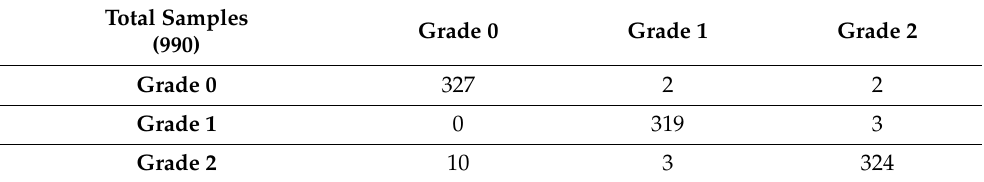
Table 9. Testing confusion matrix of RMSPROP empowered with AlexNet (augmented test